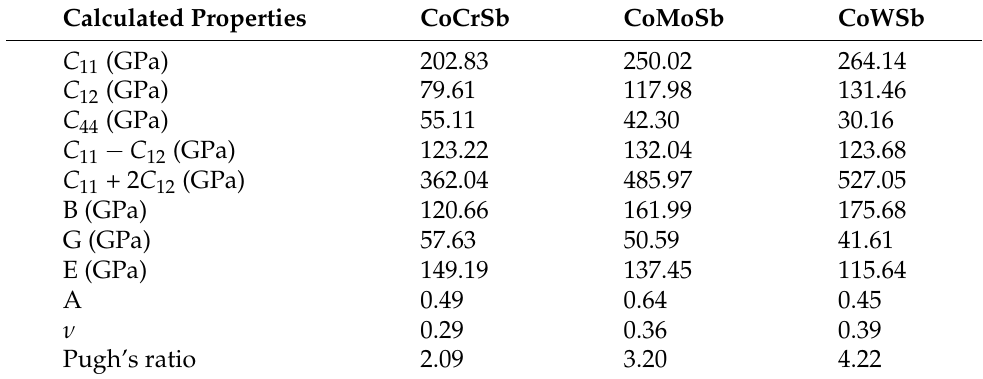
Table 5. Various mechanical properties of CoYSb (Y = Cr, Mo, W) stable phase obtained from the calculated